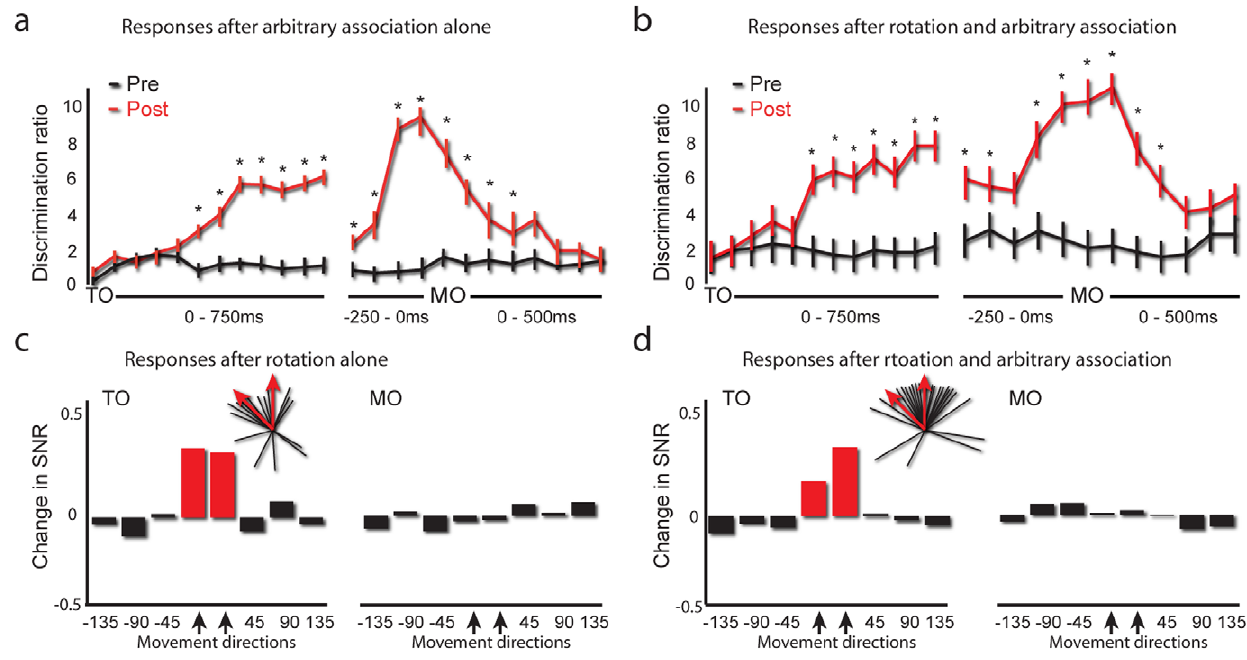
Figure 2. Simultaneous representation of multiple tasks after learning rotation and arbitrary association. (a, c) An increase in discrimination ratio for target colors (i.e. color sensitivity) after learning an arbitrary association task, either alone (n=140 cells; part a) or after learning both rotation and arbitrary association tasks (n=317 cells; part c). Black lines represent activity before learning, red lines after learning. Error bars indicate 6 1 SEM. Stars indicate a significant discrimination ratio. (b,d) Changes in the SNR for different movement directions for a rotation task either alone (n=194 cells; part b) or followed by an arbitrary association task (n=317; part d). SNR changes were normalized to be between 2 1 to 1 (0 , SNR indicates higher SNR after learning). Red bars indicate directions in which SNR significantly increased after learning. Directions are aligned according to distance from the directions used during the novel task. Inset, black lines represent the distribution of preferred directions (PDs) of neurons that significantly increased their SNR. Red arrows mark directions used during learning. doi:10.1371/journal.pone.0032986.g002 rotation or two opposing rotations (p . 0.5; not shown). This